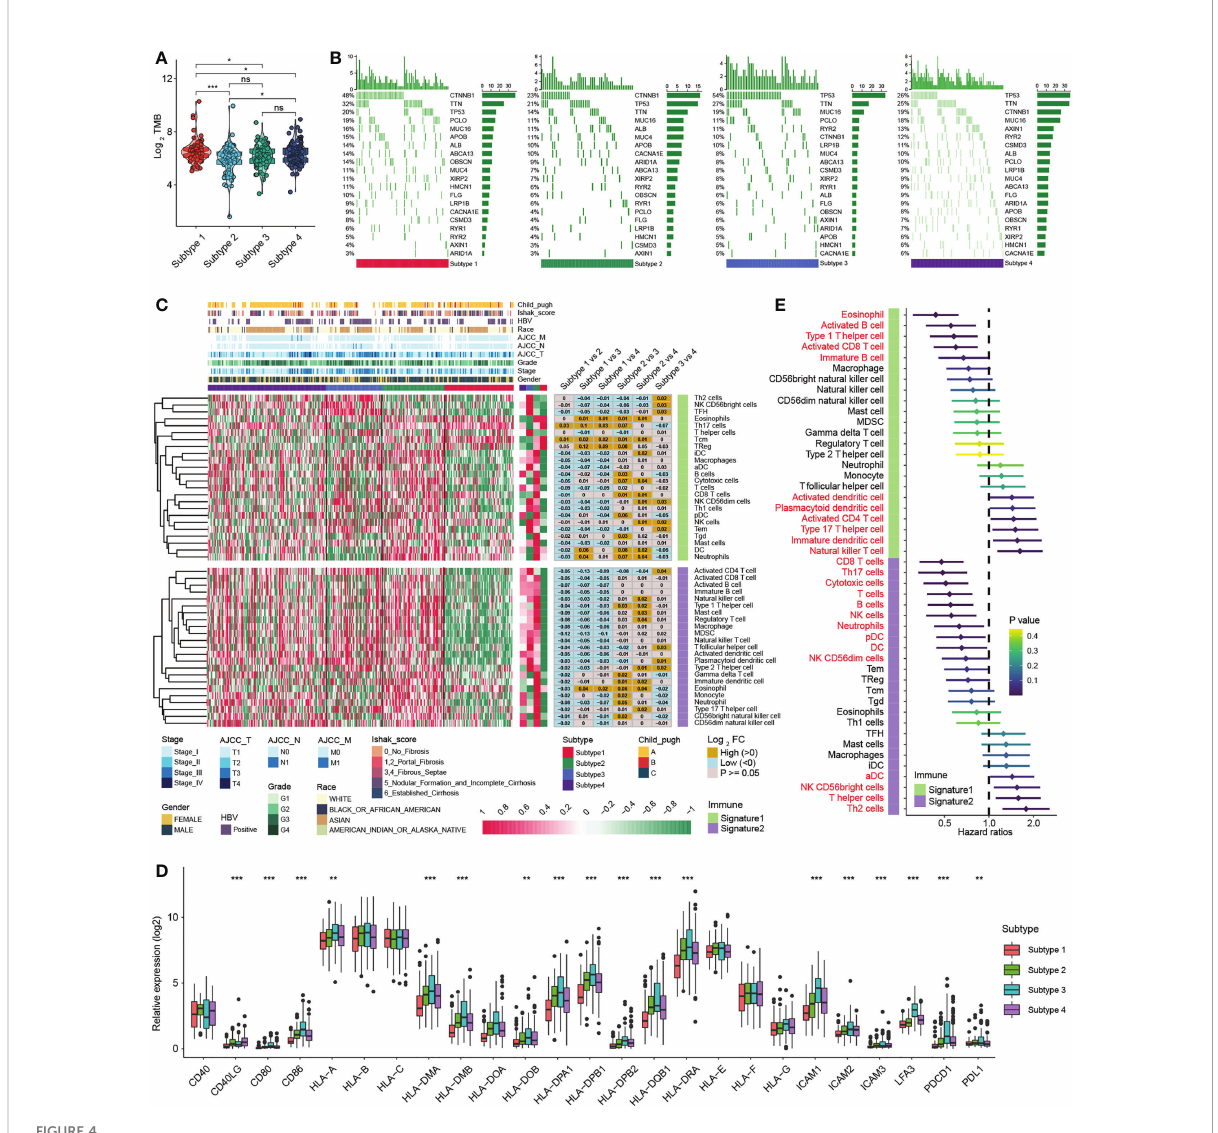
FIGURE 4 Immune in fi ltration analysis of distinct MDH subtypes in the TCGA-LIHC cohort. (A) Tumour mutation burden (TMB) in distinct MDH subtypes of the TCGA-LIHC cohort. (B) The gene mutation frequency in distinct MDH subtypes of the TCGA-LIHC cohort. Each column represents individual patients. The upper bar plot shows TMB. The number on the right indicates the mutation frequency in each gene. The right bar plot shows the proportion of each variant type. (C) Unsupervised clustering of two previously published immune cell gene signatures in distinct MDH subtypes of the TCGA-LIHC cohort. (D) Differences in the expression of MHC molecules, costimulatory molecules and adhesion molecules in distinct MDH subtypes of the TCGA-LIHC cohort. The upper and lower ends of the boxes represent the interquartile range of values. The lines in the boxes represent the median value, and black dots show outliers. The asterisks represent the statistical p-value (**P< 0.01 and ***P< 0.001). (E) Survival analyses for two previously published immune cell gene signatures based on the TCGA-LIHC